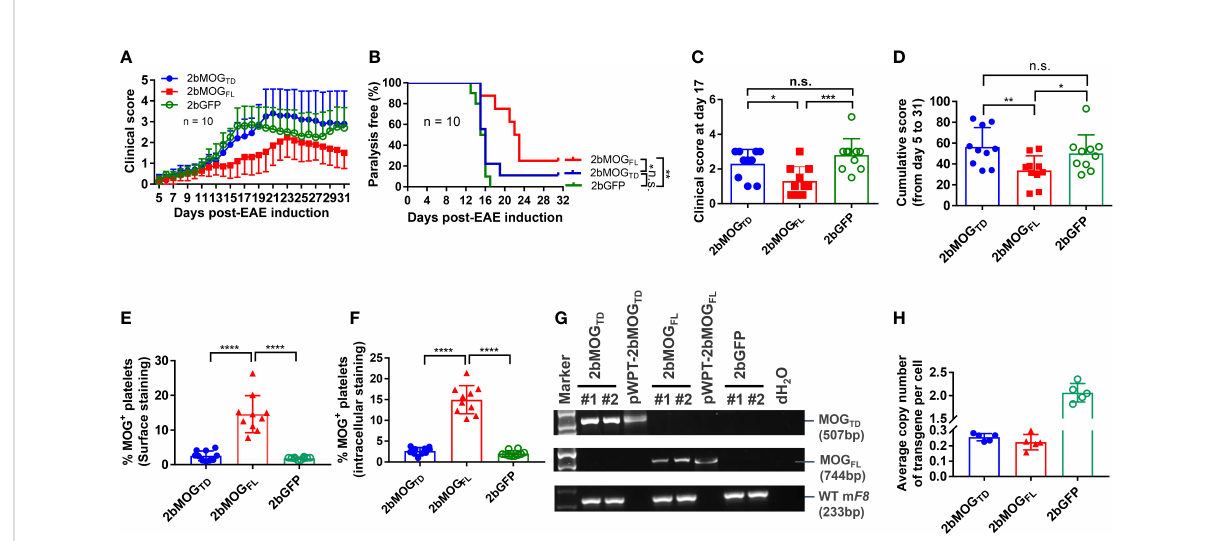
FIGURE 4 Platelet-speci fi c MOG FL , not MOG TD , expression ameliorated EAE disease severity. After lentivirus transduction of HSCs followed by HSCT and at least 3 months of BM reconstitution, mice were challenged with MOG 35-55 peptide emulsi fi ed in CFA along with intraperitoneal injection of